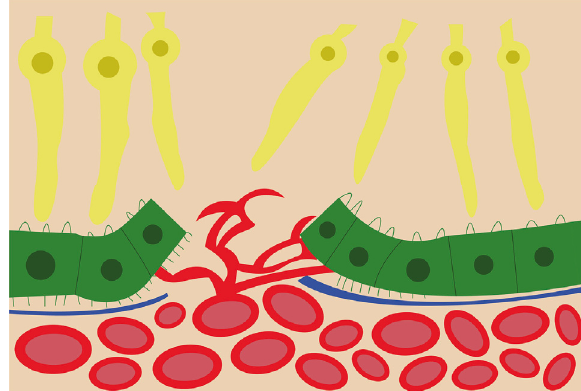
Figure 2. Schematic view of the choroidal neovascularization process. The new blood vessels from the choroid have breached the retinal pigment epithelium and are branching and invading the retina.